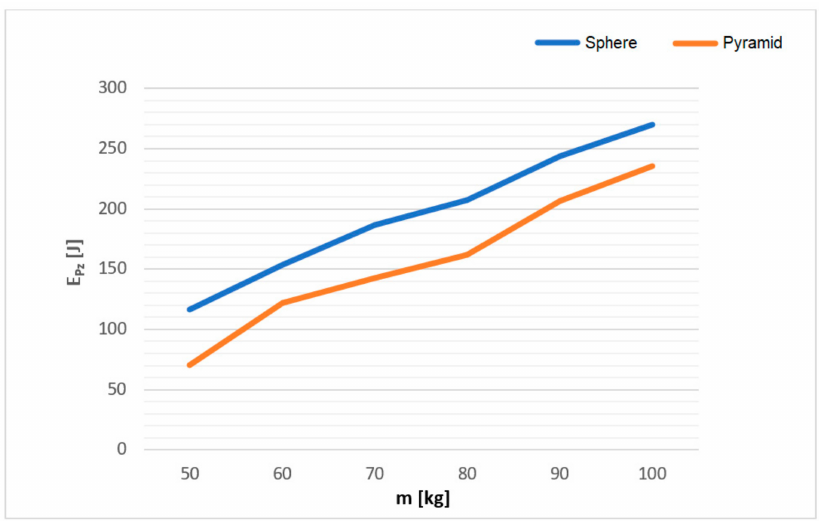
Figure 11. The correlation between the residual positional energy E Pz and the hammer mass for the impactor types